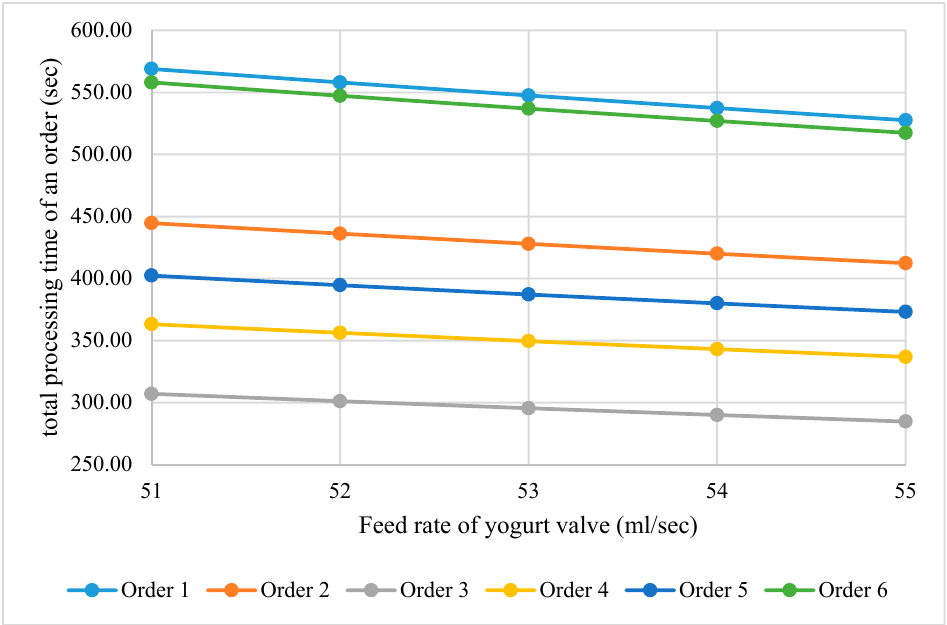
Figure 8. The effect of feed rate of yogurt valve on the total processing time of an order. The effect of changes in the yogurt feed rate on the three performance measures (average flow time, average minutes early, and average minutes past due) was analyzed. The change in the average flow time per unit change in the yogurt feed rate is almost the same in all one-dimensional rules as given in Figure 9. The average flow time in the case of SPT is lower than EDD and FCFS for different values of the feed rate of the yogurt valve.